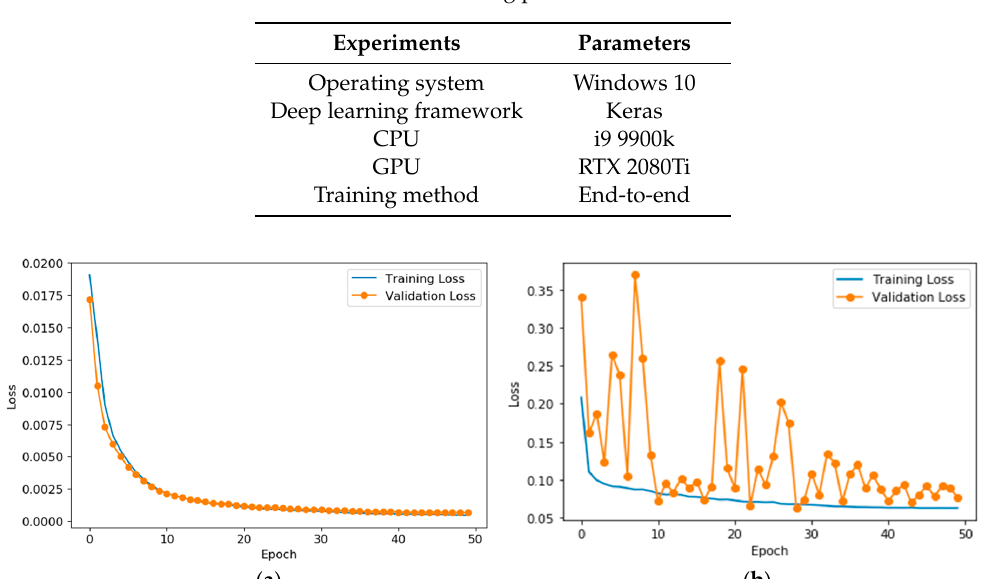
Figure 5. The training progress of two subnets. ( a ) S-net, ( b ) D-net.